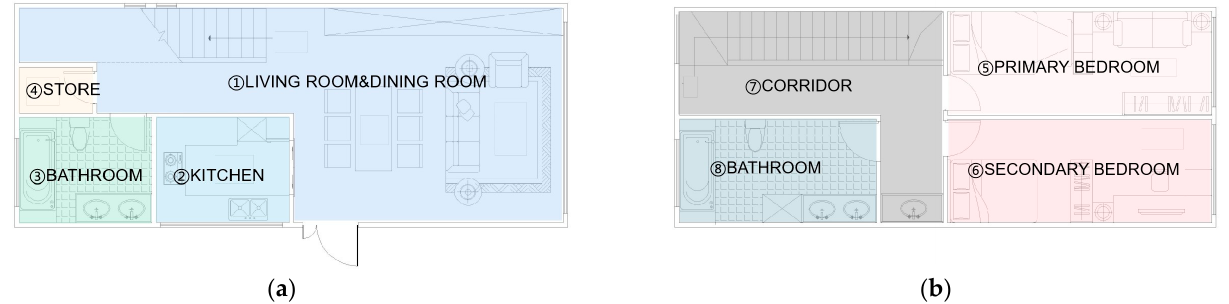
Figure 8. Layout of the modeled container housing prototype for ( a ) 1st floor; ( b ) 2nd floor.